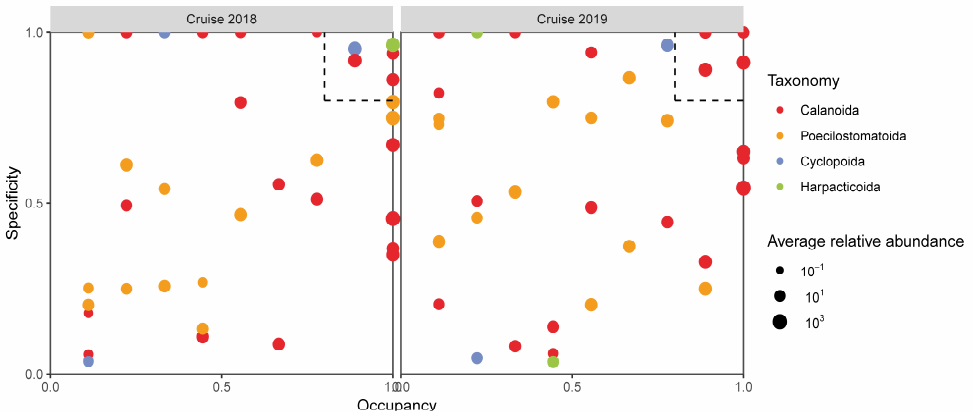
Figure 5. Specificity-occupancy plots of copepods collected from cruises in June 2018 and June 2019. The specificity of Macrosetella gracilis was 96.37% with a mean abundance of 384.04 ±